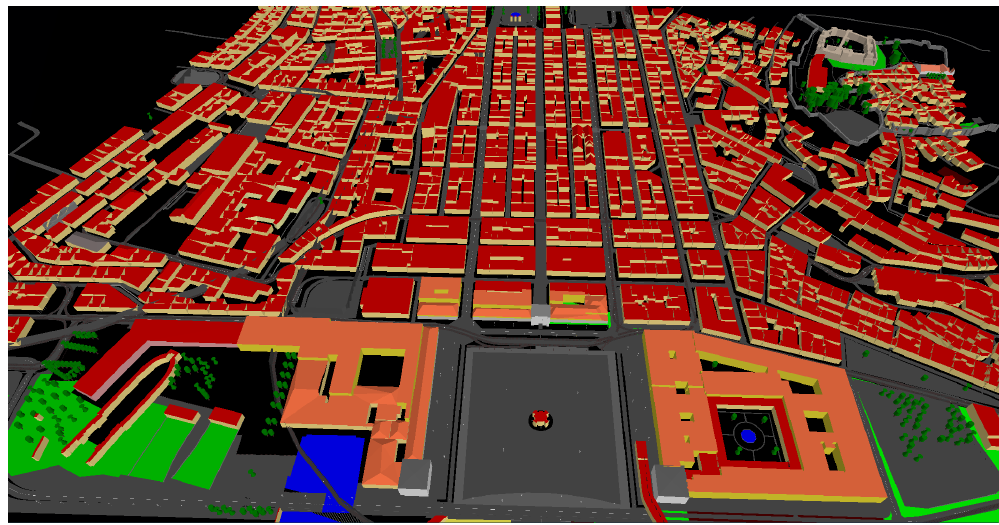
Figure 1. Generated virtual representation of Lisbon’s